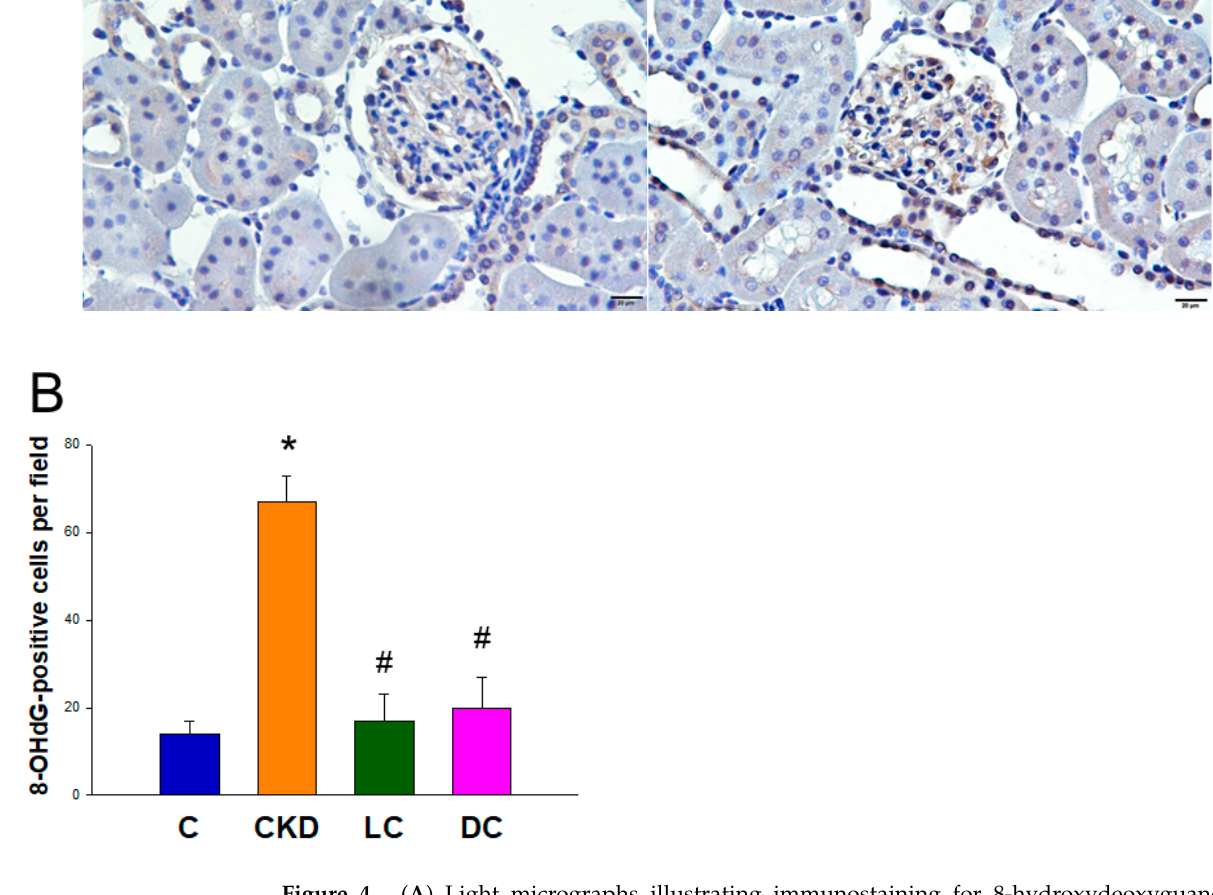
Figure 4. ( A ) Light micrographs illustrating immunostaining for 8-hydroxydeoxyguanosine (8-OHdG) in the offspring kidneys exposed to maternal chronic kidney disease (CKD), L -cysteine (LC), or D -cysteine (DC). ( B ) Quantitative analysis of 8-OHdG-positive cells per microscopic field (×200). n = 8/group; * p < 0.05 vs. C; # p < 0.05 vs. CKD.